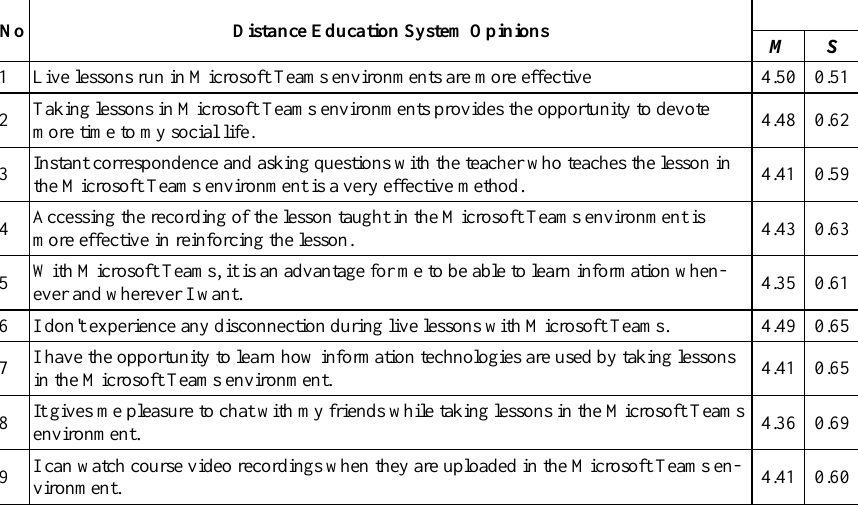
Table 7. Opinions of mechanical engineer programme candidates on the distance education